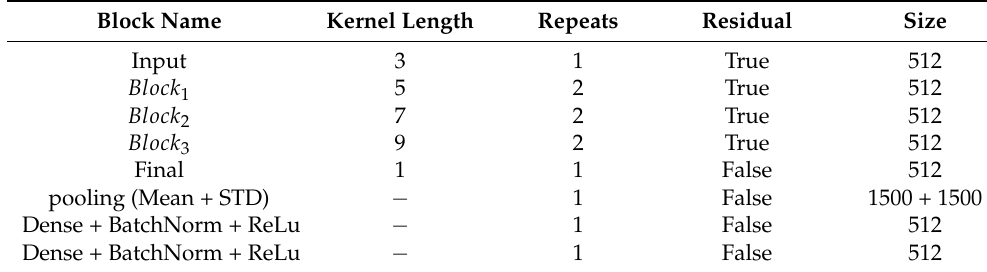
Table 2. Quartznet architecture summary [21].